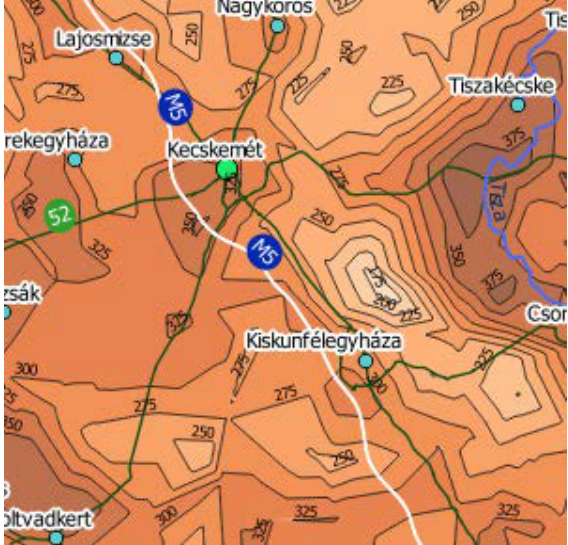
Figure 17. The Danube–Tisza Interfluve on scale 1:750 000. The thematic layers: blue lines – rivers; white – motorway, green – primary road; towns and cities with white shadow.